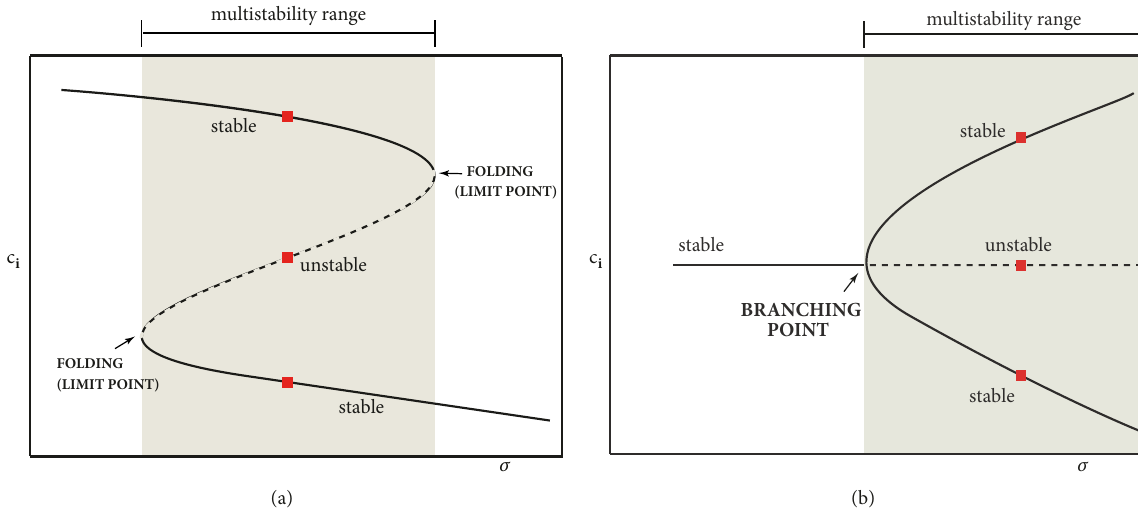
Figure 2: Two types of bifurcations leading to multistationarity. (a) Folding: multistationarity arises due to a folding of the equilibrium manifold. As it is seen in the figure, the multistability region is enclosed by two folding (or limit point) bifurcations with respect to a mass conservationconstant. Importantly, the three equilibria indicated in the figure by red squares correspond to different vectors z . (b) Branching: multistationarity arises via equilibrium branching; in this case the three equilibria indicated by red squares correspond to the same vector z (there are three different values of 𝜉 for a given z